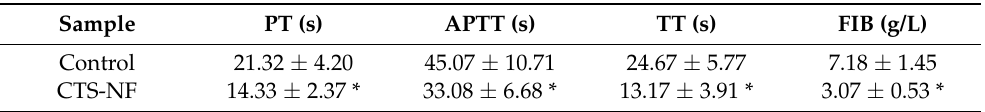
Table 5. Measurement results of four coagulation indicators.